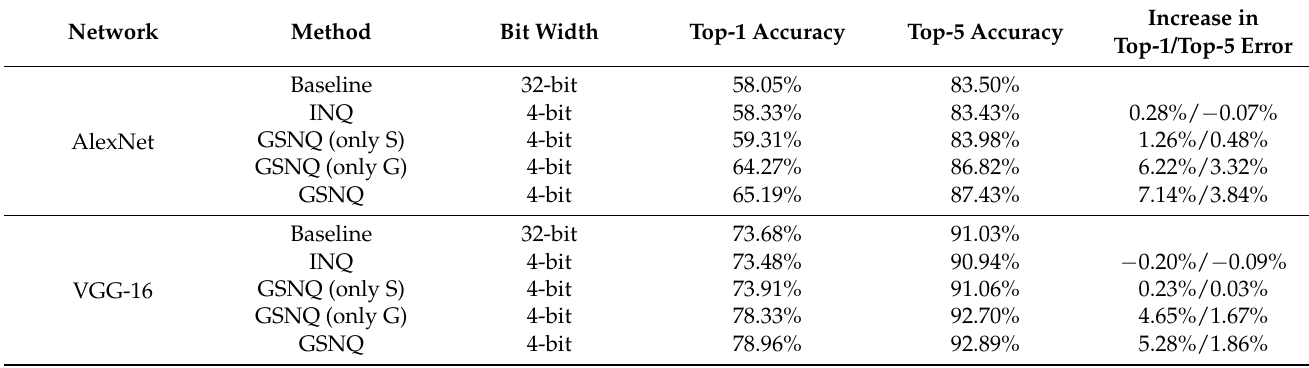
Table 7. Ablation experiments on 4-bit quantization on the Mini-ImageNet